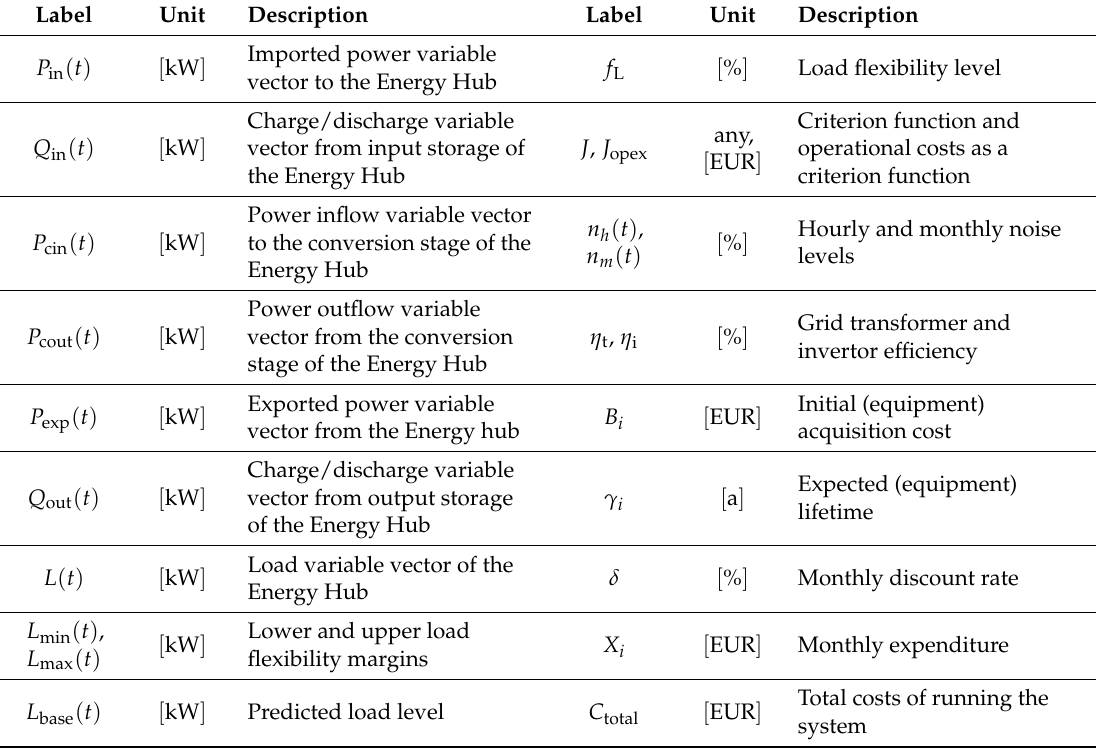
Table 1. Variable nomenclature